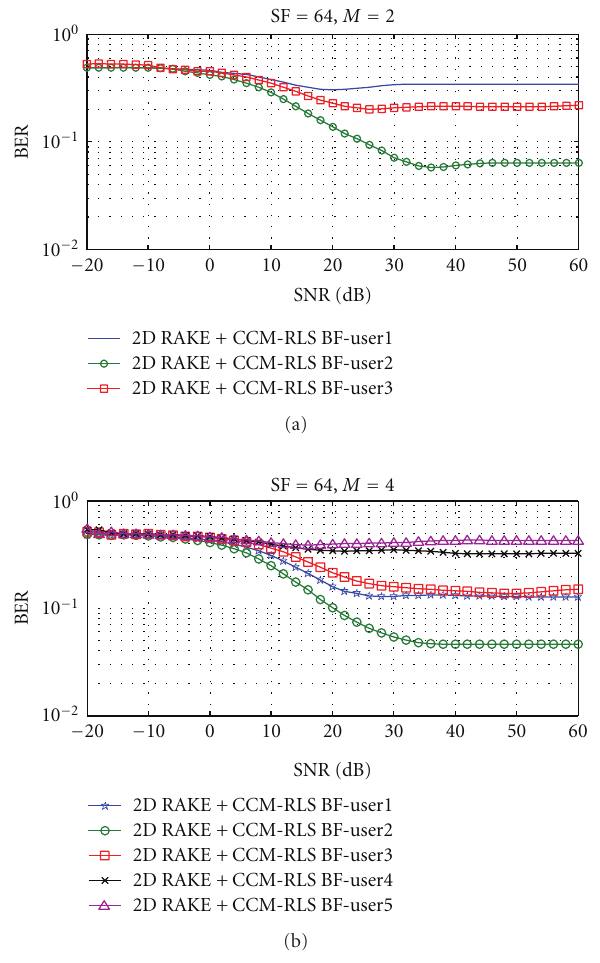
Figure 10: Performance of proposed receiver in 3-path AWGN fading channel and SF = 64 for (a) 2-element antenna array considering 3 users, (b) 4-element antenna array considering 5